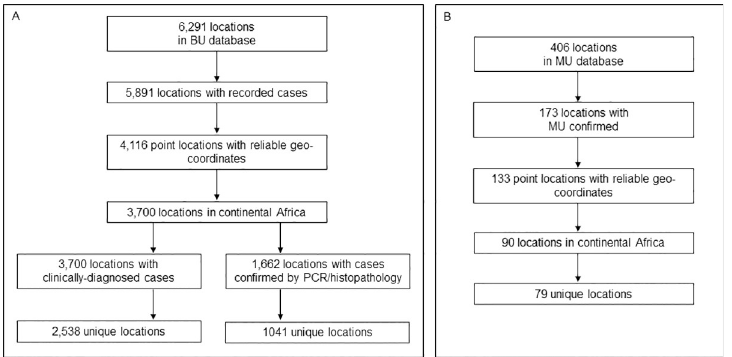
Fig 1. Selection of model occurrence points from Buruli ulcer database. Selection is shown separately for Buruli ulcer occurrences (A) and environmental occurrences of Mycobacterium ulcerans